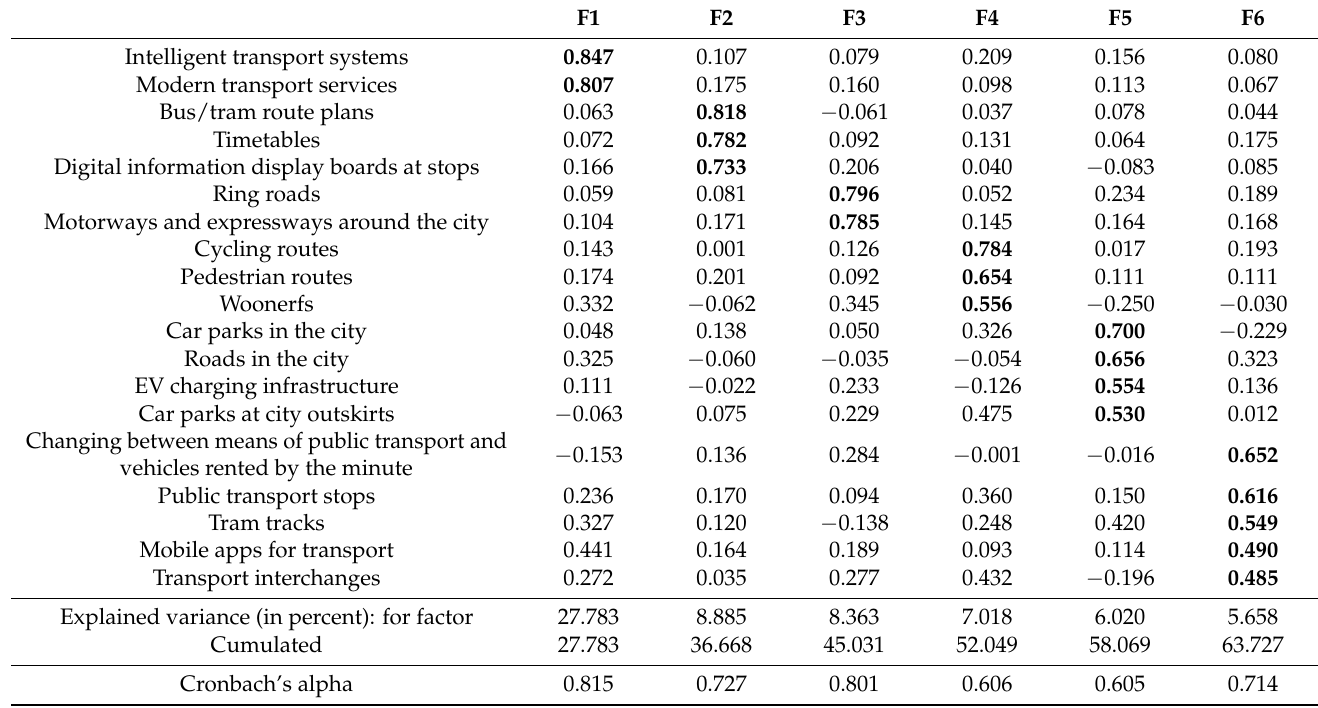
Table 7. Results of exploratory factor